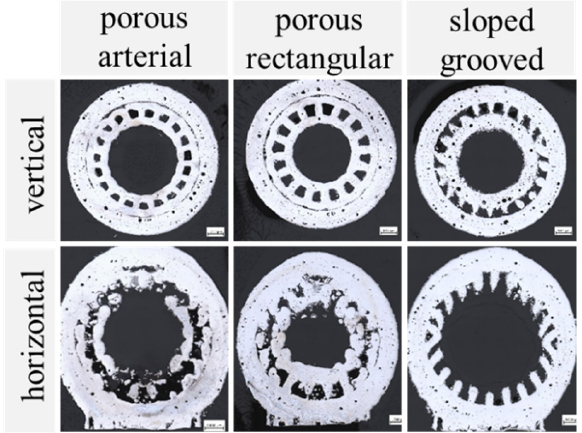
Figure 11. Alternative wick concepts printed vertically (top row) and horizontally (bottom row).